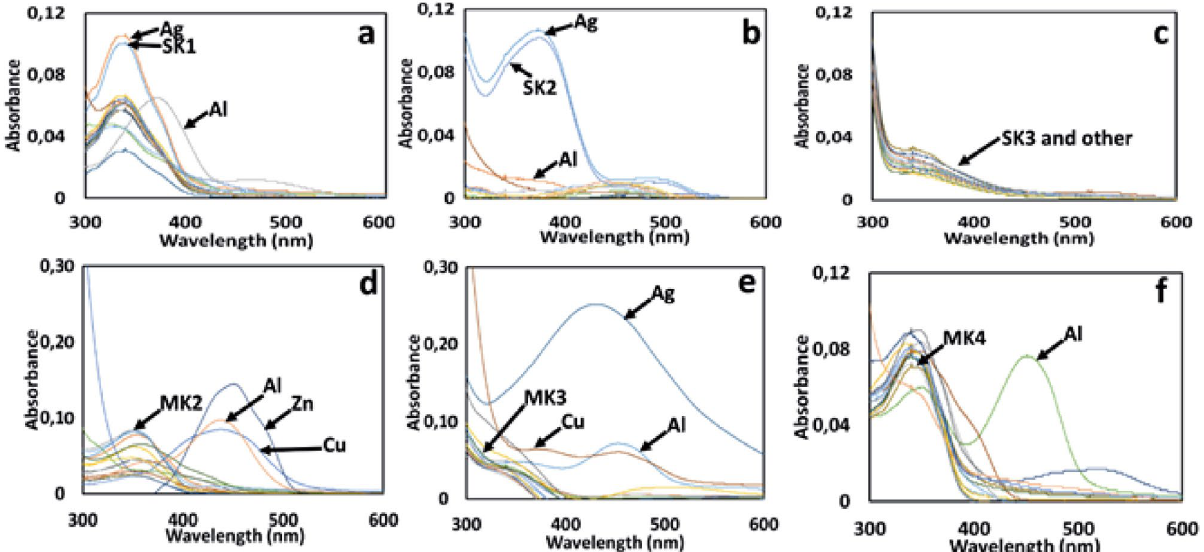
Fig. 1. UV–vis absorption spectra of (1µM); (a) SK-1 , (b) SK-2 , (c) SK-3 , (d) MK-2 , (e) MK-3 , and (f) MK-4 in the presence of several metal ions such as Li + , Na + , Ag + , Ca 2+ , Ba 2+ , Co 2+ , Cs + , Cu 2+ , Mg 2+ , Hg 2+ , Mn 2+ , Pb 2+ , Ni 2+ , Sr 2+ , Zn 2+ and Al 3+ (10 eq. for each metal